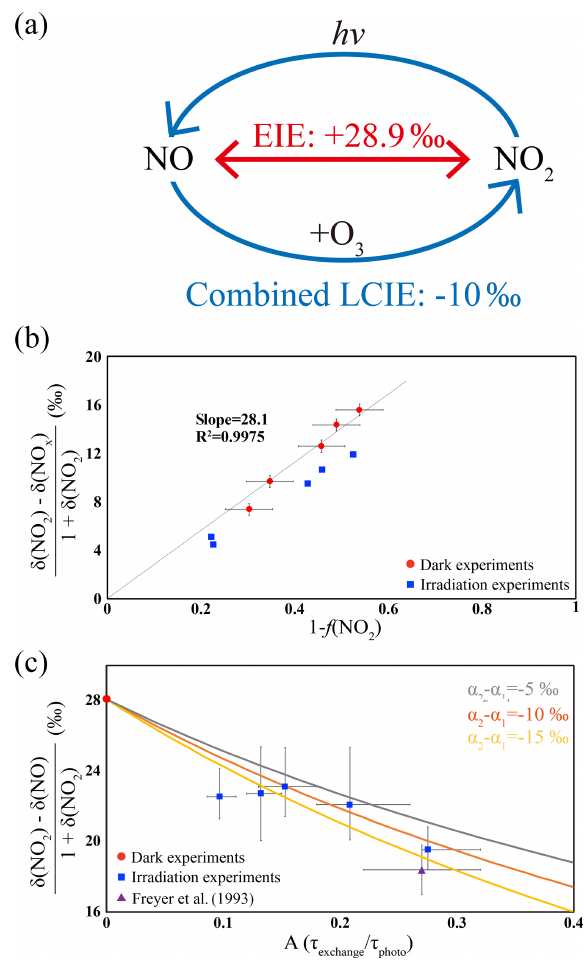
Figure 1. (a) A sketch of the isotopic fractionation processes be- tween NO and NO 2 ; both fractionation factors are determined in this work. (b) Results from five dark experiments (red circles) yielded a line with slope of 28.1‰ and an α (NO 2 –NO) value of 1.0289, while the results from five UV irradiation experiments (blue squares) showed a smaller slope. (c) Results from five UV irradia- tion experiments (blue squares) and a previous field study (purple triangle), comparing to the dark experiments (red circle). The three lines represent different ( α 2 − α 1 ) values: the ( α 2 − α 1 ) = − 10‰ line showed the lowest RMSE to our experimental data as well as the previous field observations. The error bars in panels (b) and (c) represented the combined uncertainties of NO x concentration mea- surements and isotopic